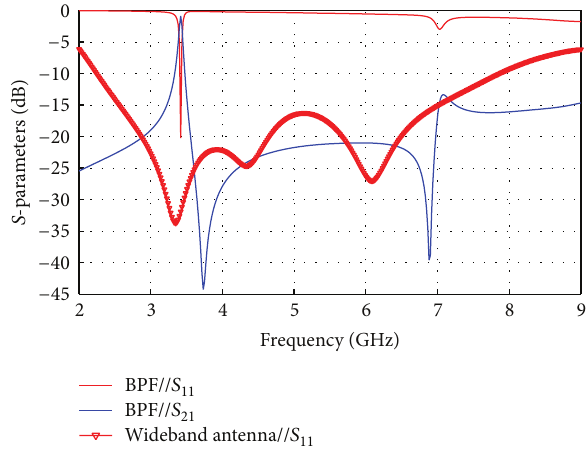
Figure 3: Simulated and measured 𝑆 -parameters of the OLR-based bandpass filter.